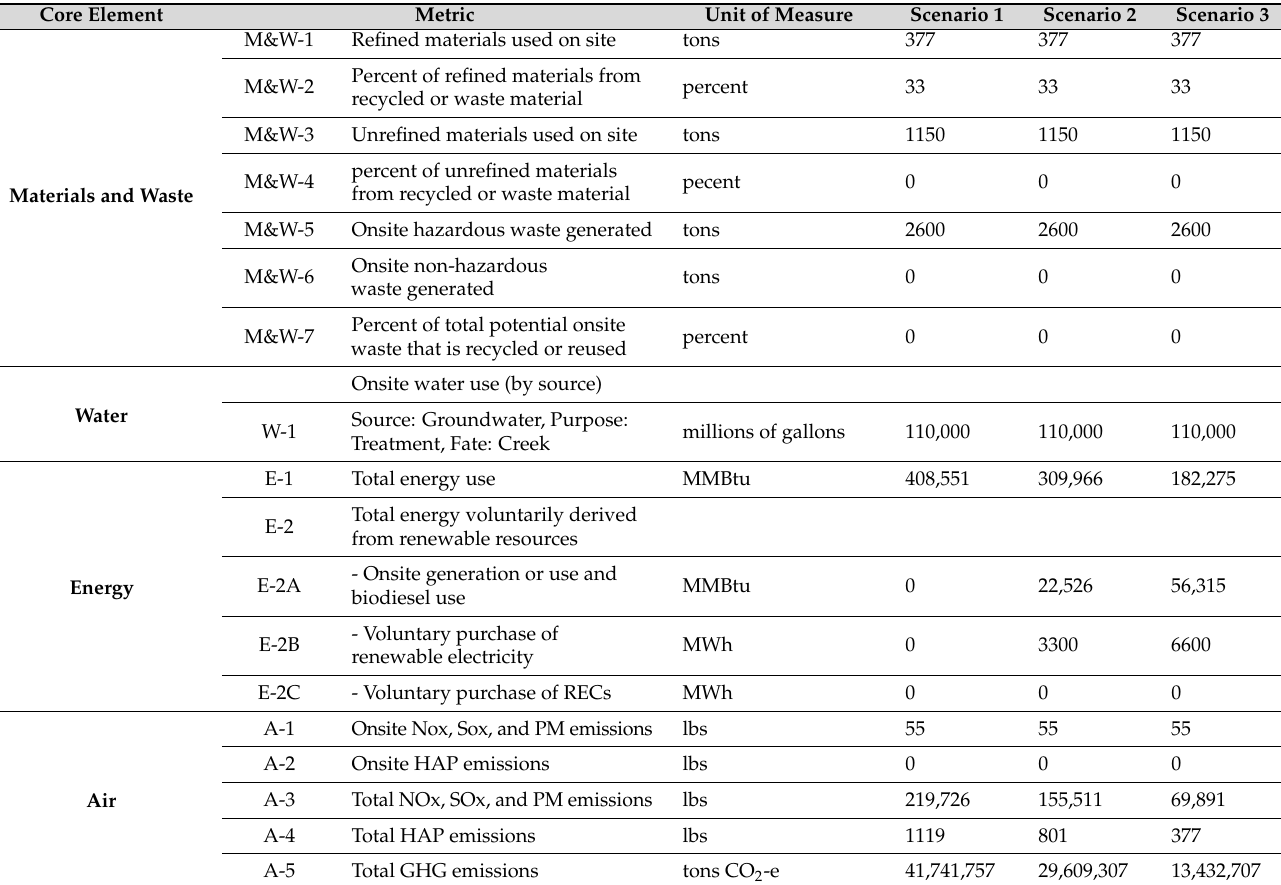
Table 3. Summary of the environmental footprint of cleanup under all scenarios.